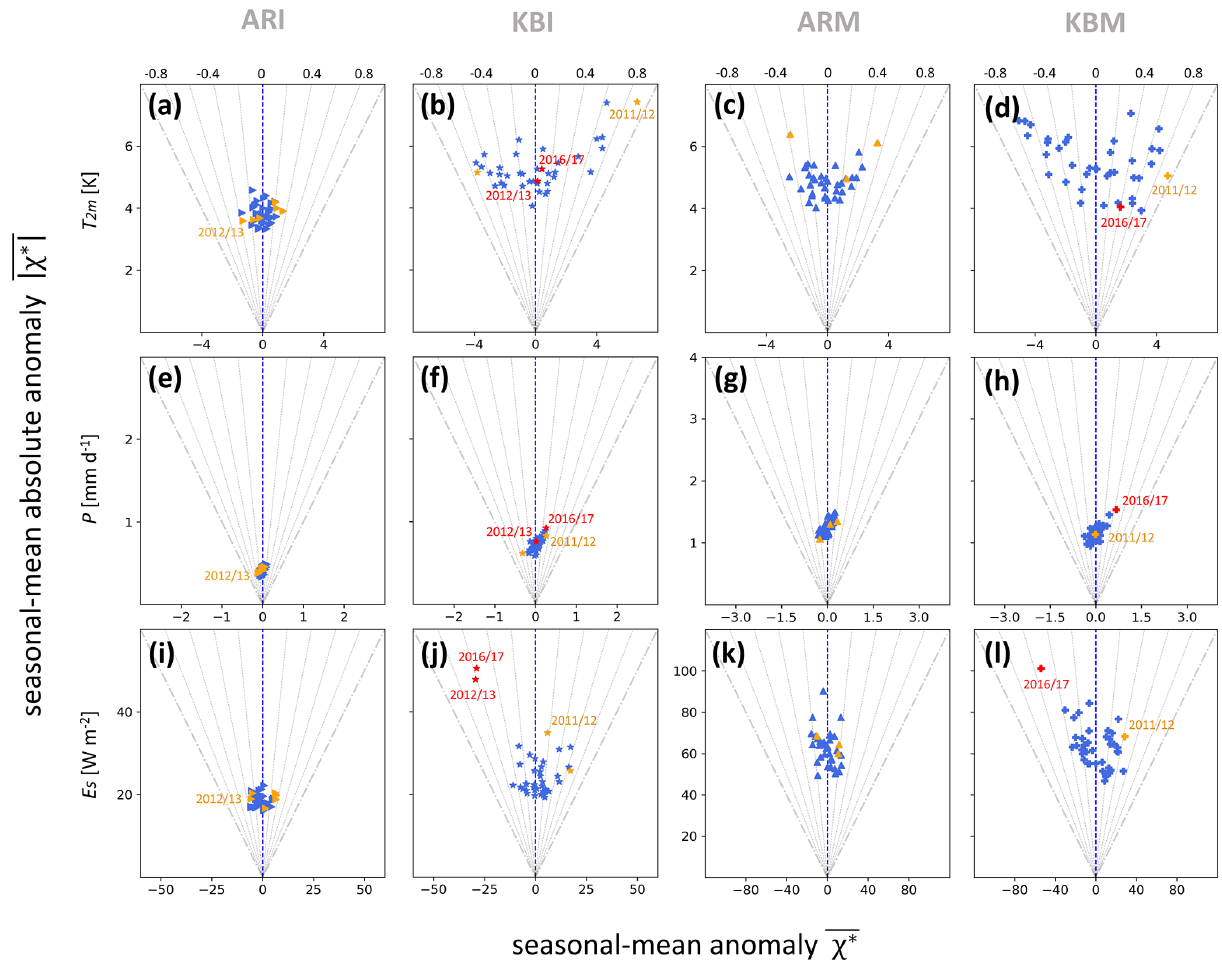
Figure 5. Seasonal-mean anomalies ( χ ∗ , along x axis) vs. seasonal-mean absolute anomalies ( | χ ∗ | , along y axis) in DJF for (a–d) T 2m (K), (e–h) P (mmd − 1 ) and (i–l) E S (Wm − 2 ) in sub-regions ARI, KBI, ARM and KBM. The ratio of the two measures, χ ∗ = ± 1 is shown by stippled grey lines, and χ ∗ visualized by grey dashed lines. χ | χ ∗ | markers represent extreme (anomalous) seasons (see Sect. 2.3), and selected case study seasons are labeled. Remaining sub-regions are shown in Fig.